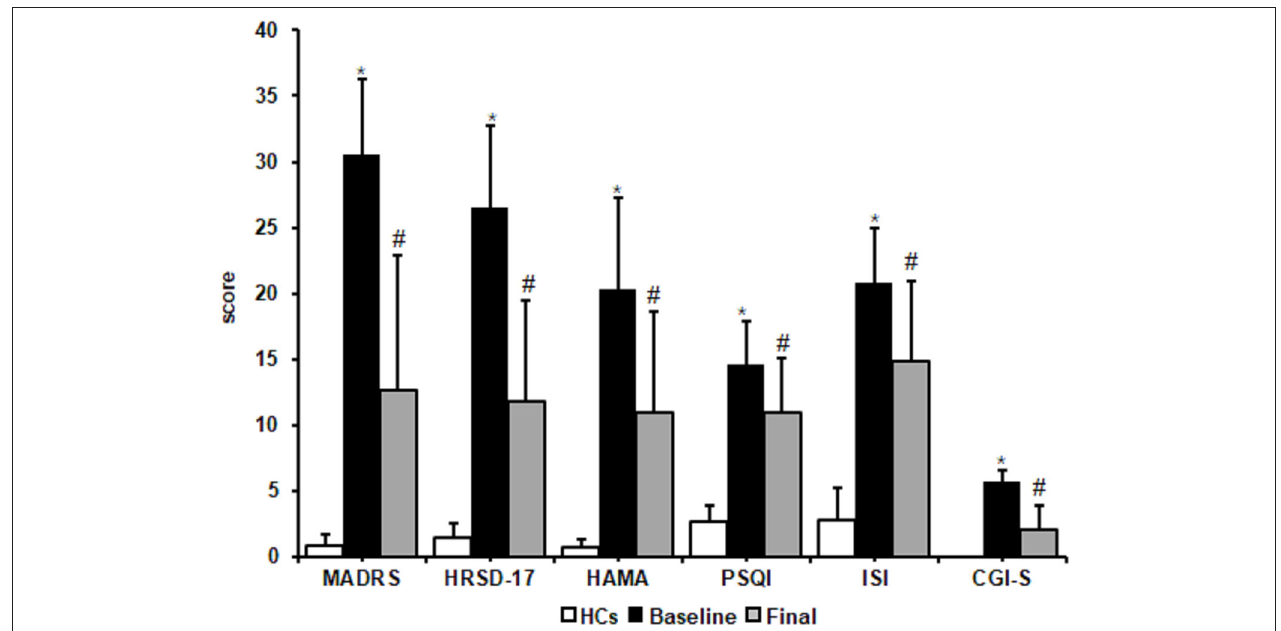
FIGURE 1 | Effects of escitalopram on clinical symptoms. Clinical symptoms significantly decreased after 8 weeks of treatment. MADRS, Montgomery-Asberg Depression Rating Scale; HRSD-17, 17-item Hamilton Rating Scale for Depression; HAMA, Hamilton Anxiety Scale; PSQI, Pittsburgh Sleep Quality Index; ISI, Insomnia Severity Index; CGI-S, Clinical Global impressions-severity. The data are expressed as mean ± SD. n = 13 MDD patients. n = 13 healthy controls. * p < 0.05, different from healthy controls; # p < 0.05, different from baseline. HCs, healthy controls; Baseline, MDD patients before treatment; Final, patients at the end of 8 weeks of escitalopram